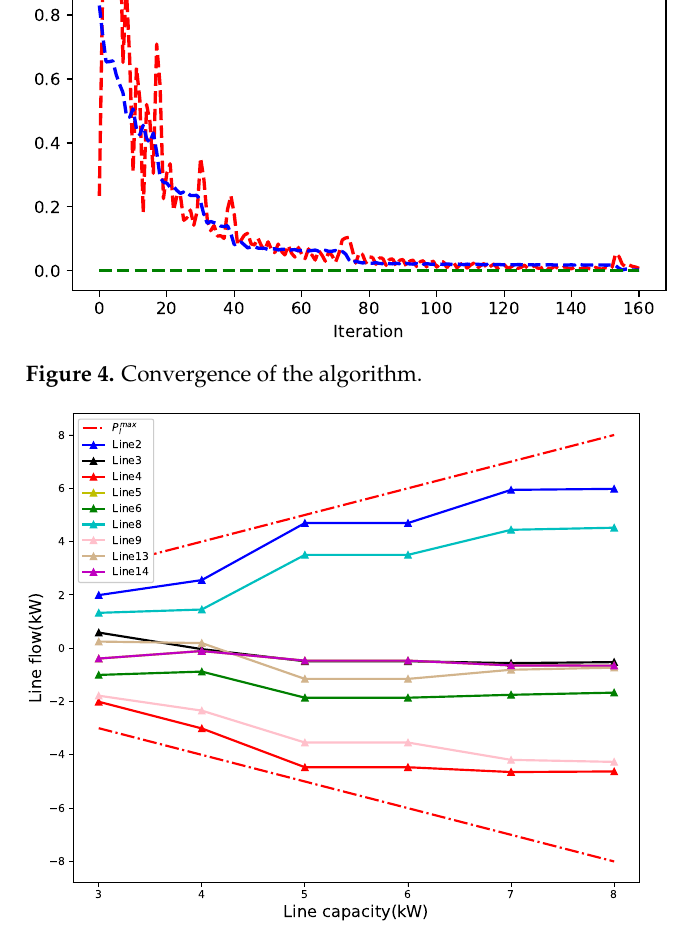
Figure 5. Power flow in different lines under different line Figure 6. Power flow in different lines under different line capacities.